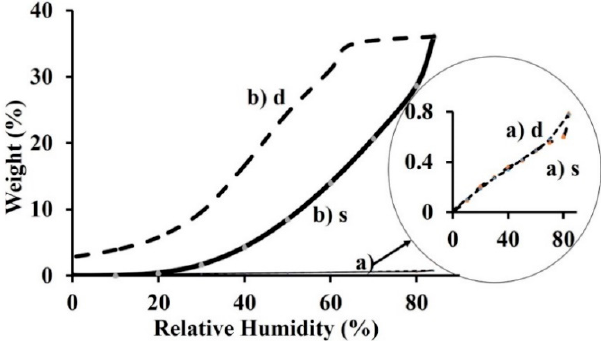
Figure 4. The sorption (s)/desorption (d) isotherms of (a) PET and (b) C films.